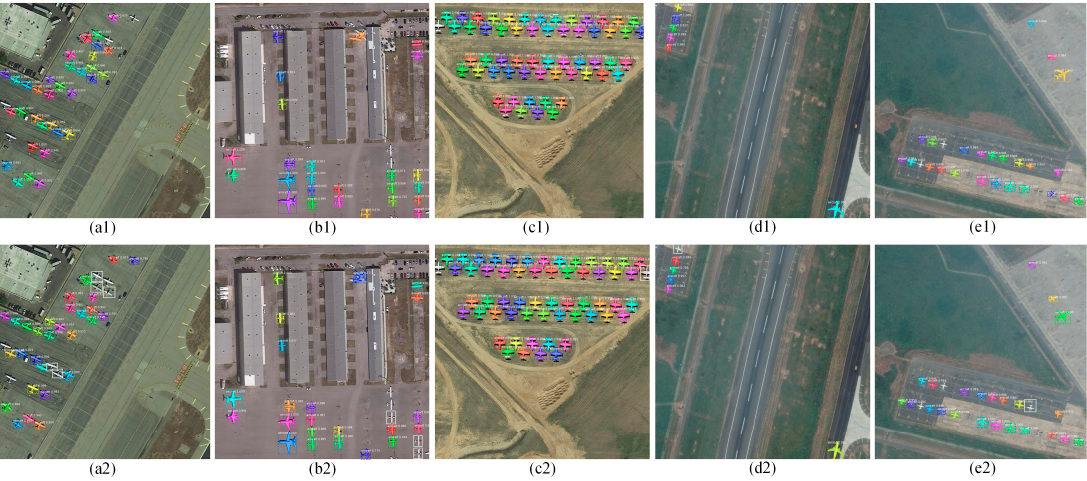
Figure 6. Detection performance comparison. The top row results are based on our method and the bottom row results are based on Mask R-CNN. ( a1 – e1 ) SCMask R-CNN; ( a2 – e2 ) Mask R-CNN